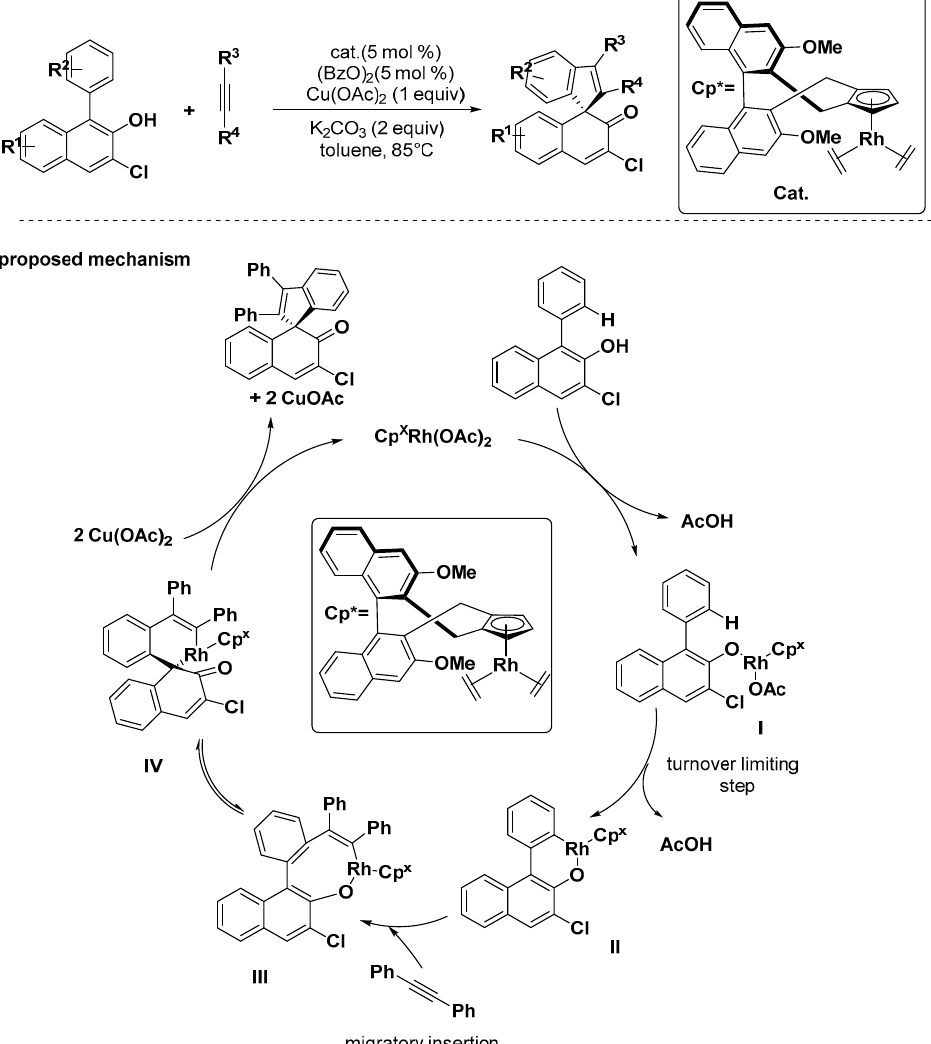
Scheme 36. Rh(III)-catalyzed asymmetric dearomatization of naphthols.